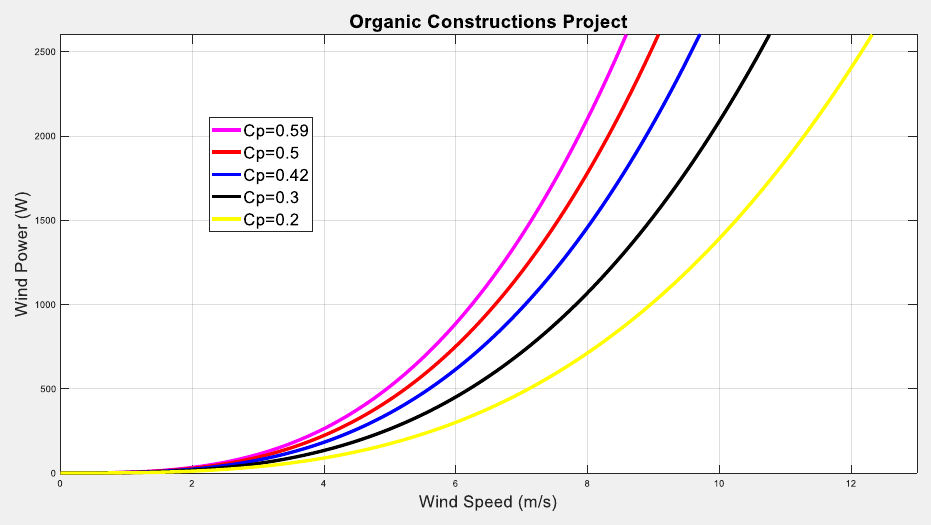
Figure 16. Wind speed vs. power at different values of Betz coefficient.